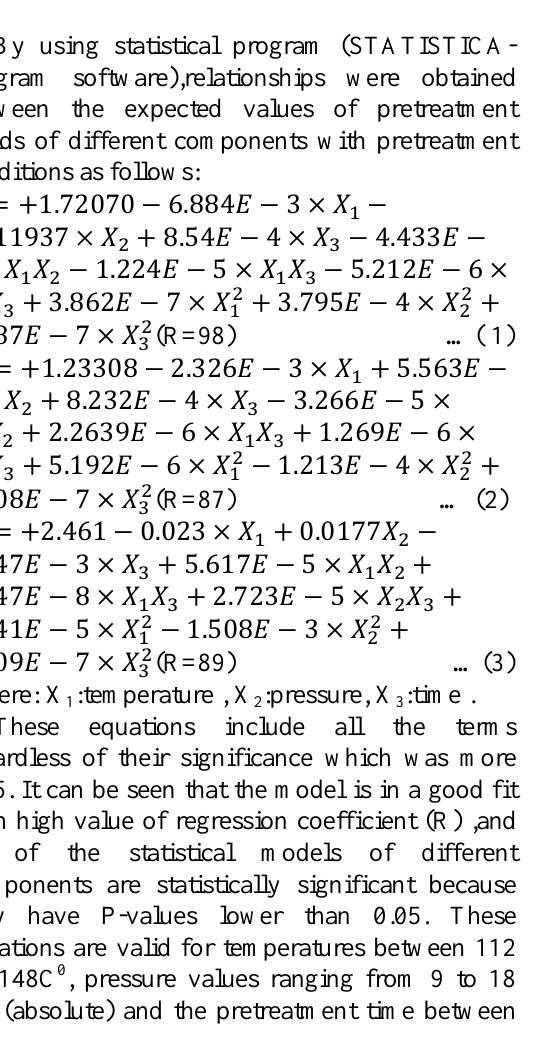
Fig. 2-B. X: time (min), Y: Pressure